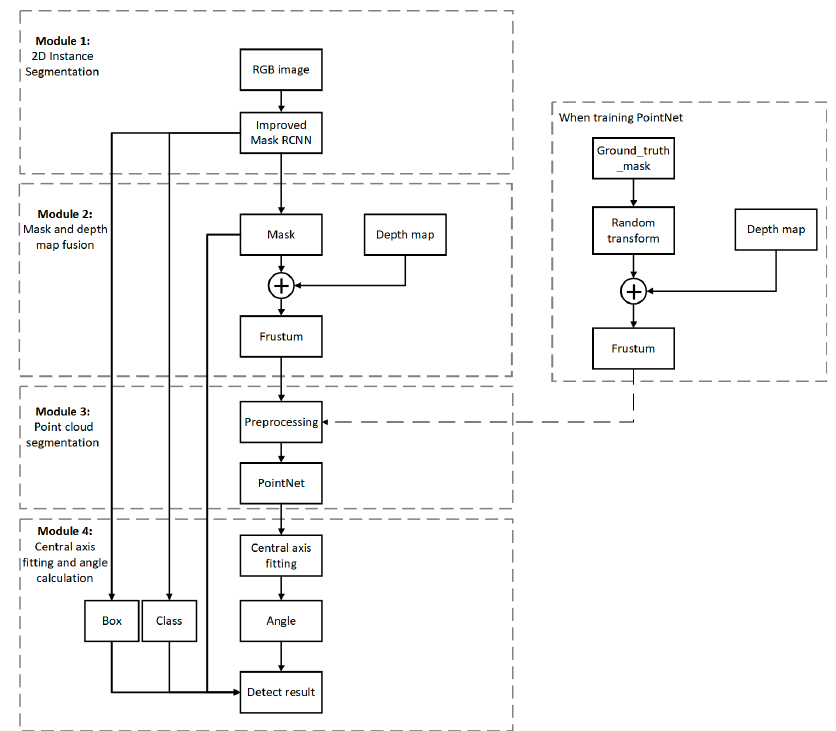
Figure 1. Overall detection process.